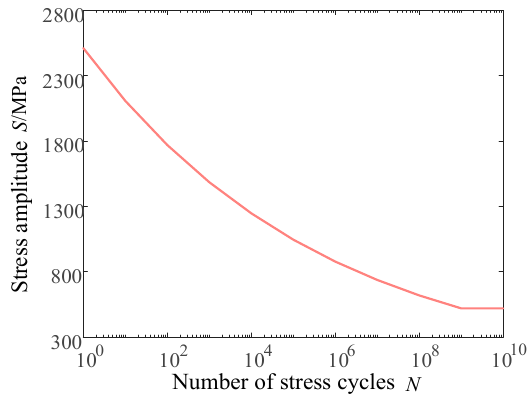
Figure 16. S–N curve of 30CrMnSi.